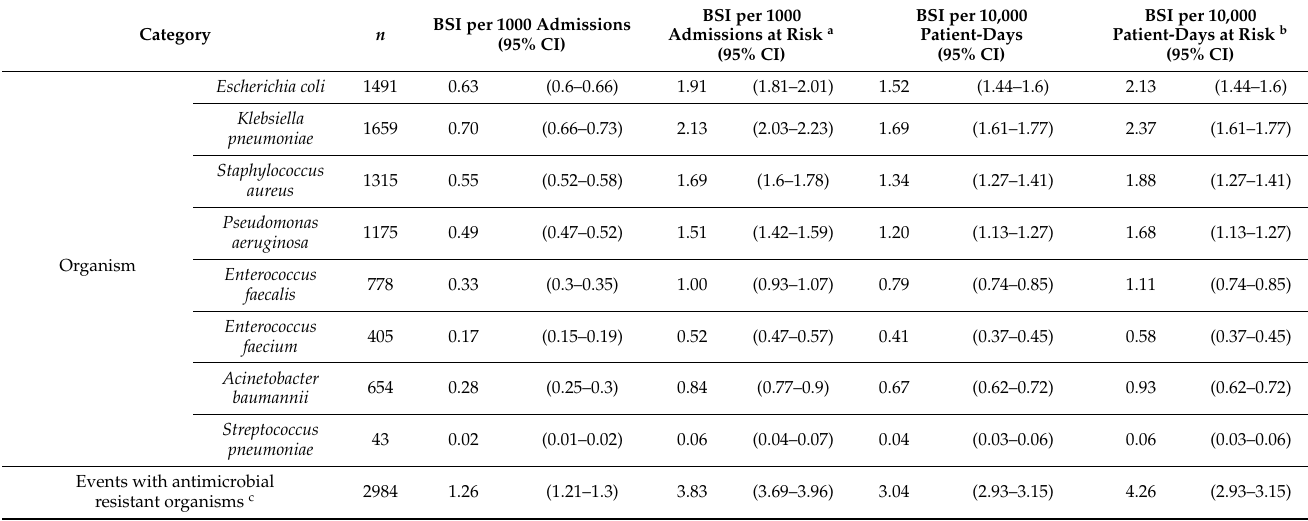
Table 2. Incidence rates of hospital-onset bloodstream infections (HO-BSIs) caused by sentinel bac- teria among adult patients, Israel, 2018–2019. Table 2. Cont.